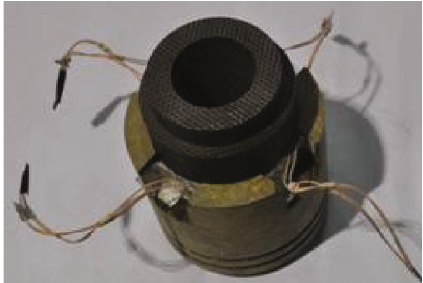
Figure 9: The throat insert bonded with strain